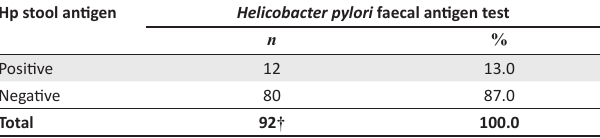
FIGURE 5: Positive Helicobacter pylori faecal antigen test (presence of horizontal lines on C & T) above. TABLE 6: Post-treatment Helicobacter pylori faecal antigen test.